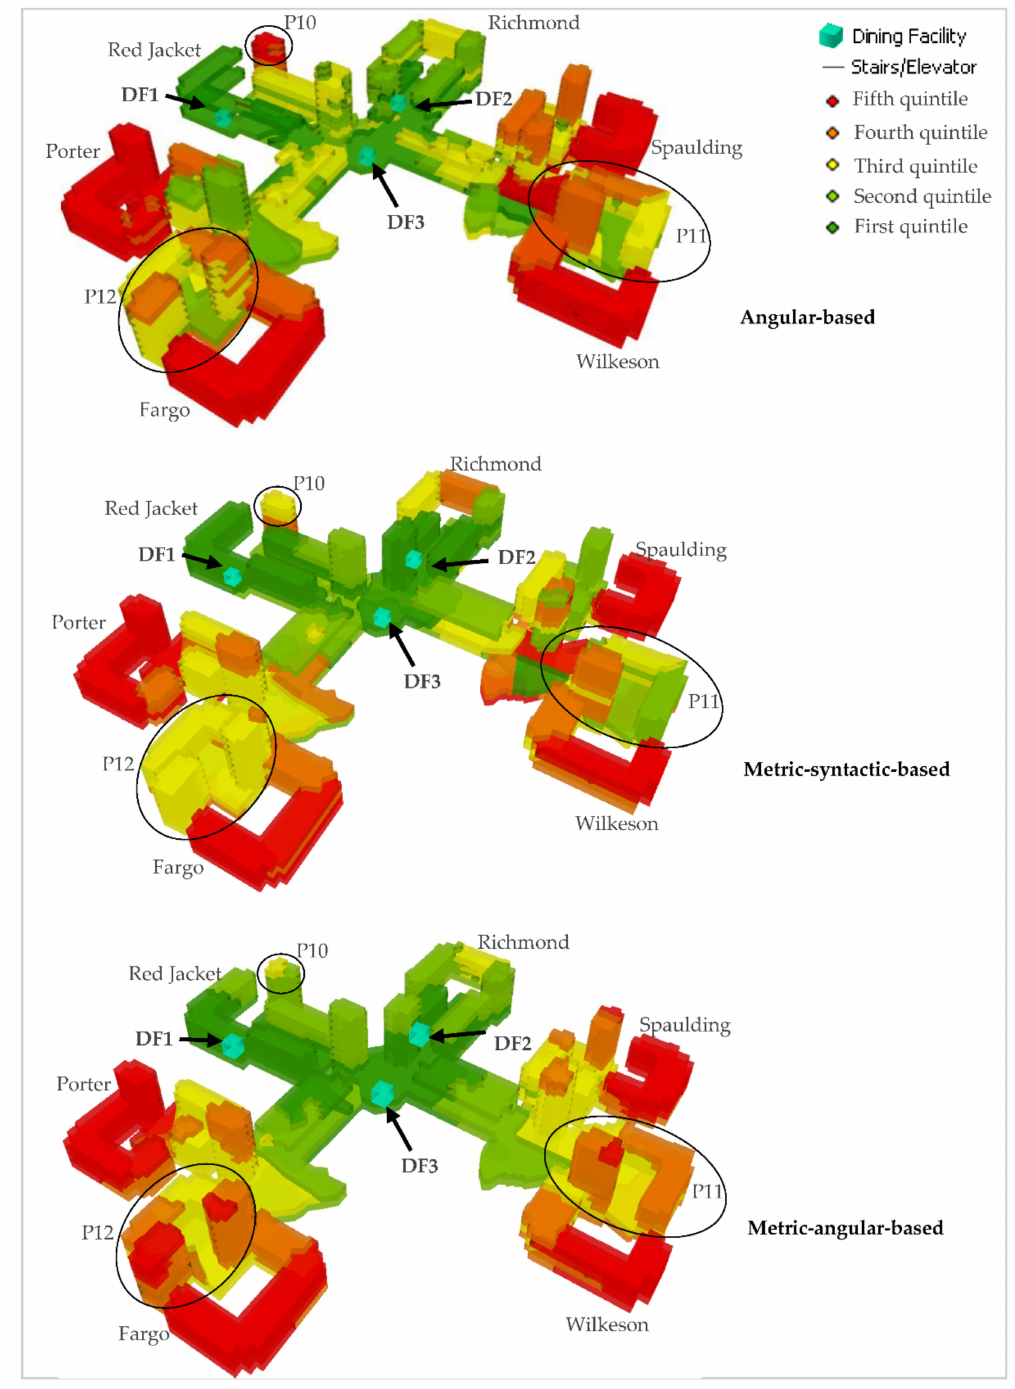
Figure 23. Angular, metric-syntactic, and metric-angular accessibility to three dining facilities: classification in